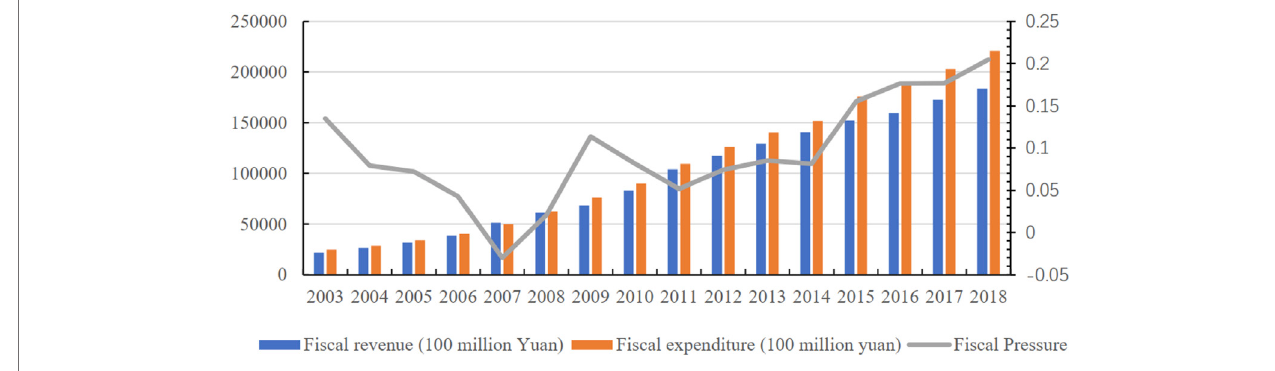
FIGURE 3 | China ’ s fi scal revenue and expenditure, 2003 –